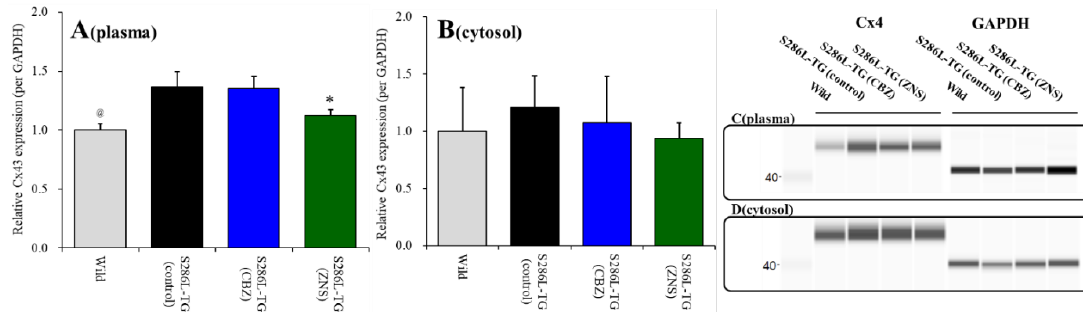
Figure 1. Effects of subcutaneously subchronic administration of therapeutic-relevant doses of carbamazepine (CBZ) and zonisamide (ZNS) (25 mg/kg/day) for seven days on connexin 43 (Cx43) expression in the thalamic plasma membrane (panel A ) and cytosol (panel B ) fractions. The pseudo-gel images using simple Western results using anti-glyceraldehyde-3-phosphate dehydrogenase (GAPDH) and anti-Cx43 antibody for blotting of plasma membrane (panel C ) and cytosol (panel D ) fractions. In panels 2A and 2B, ordinate: mean ± SD ( n = 6) of relative protein level of Cx43. @ p < 0.05 relative to control by student’s t -test, and * p < 0.05 relative to control by one-way analysis of variance (ANOVA) with Tukey’s post hoc test.